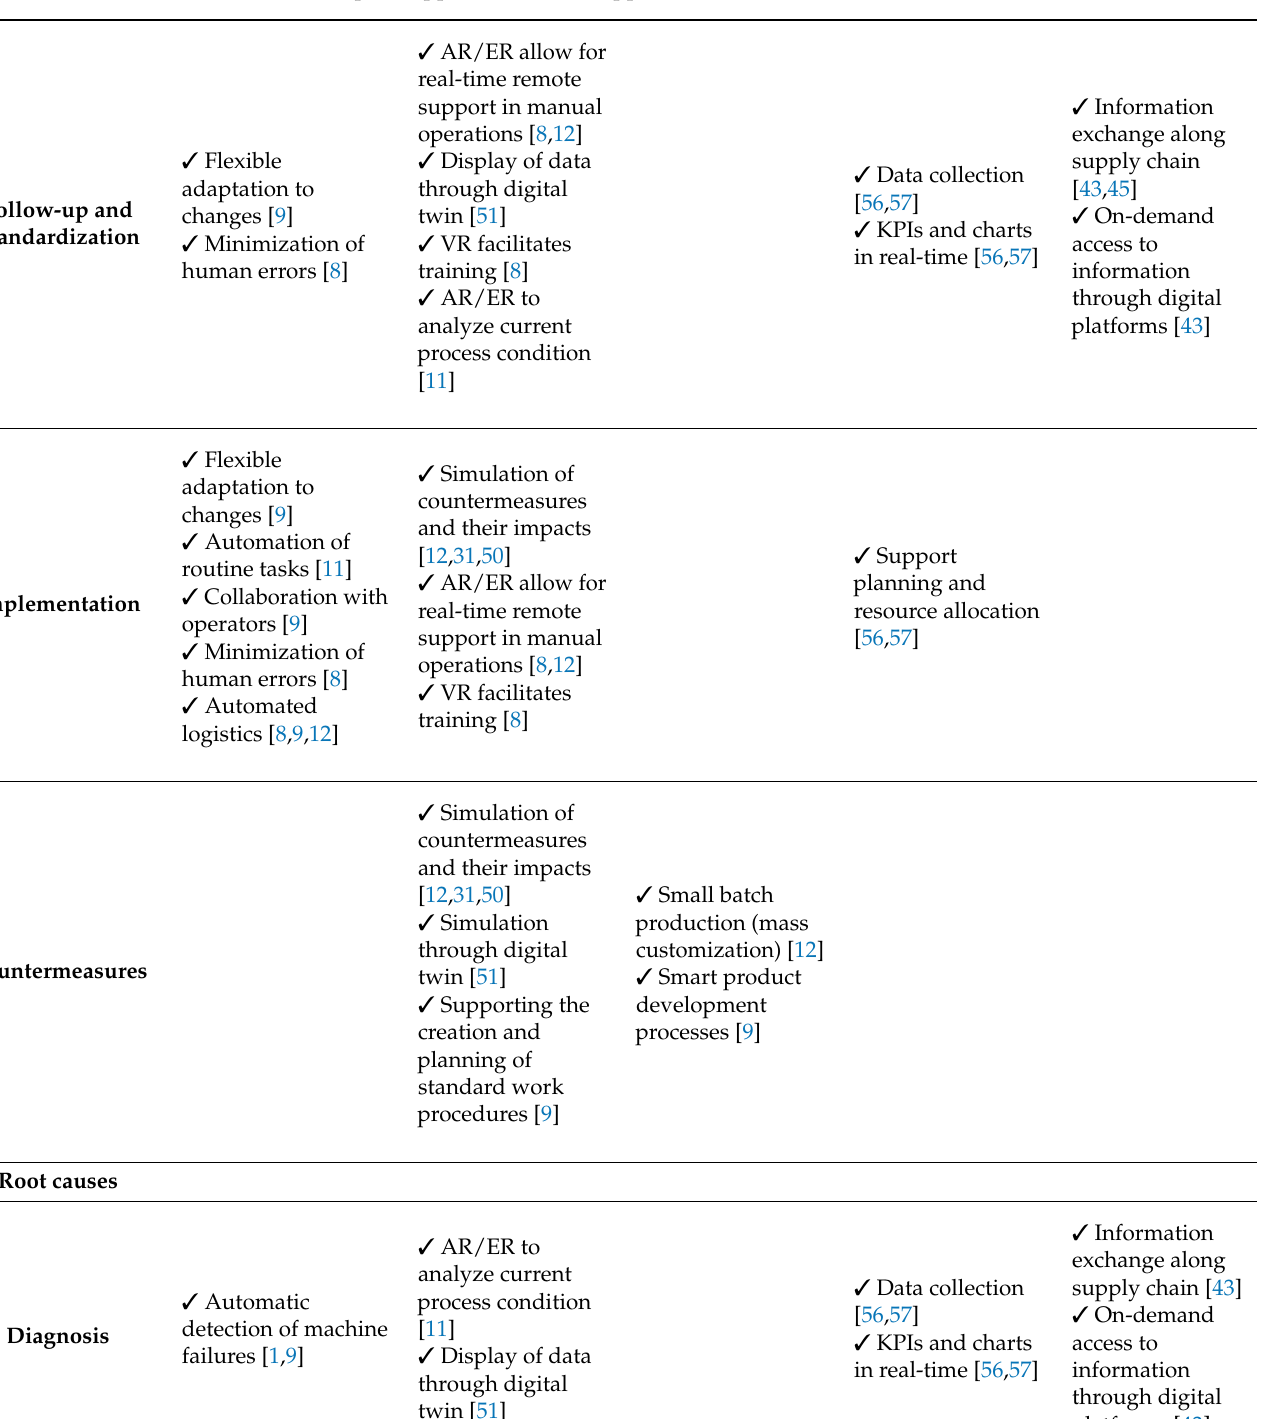
Table A2. Conceptual approaches for the application of I4.0 to LM/CI